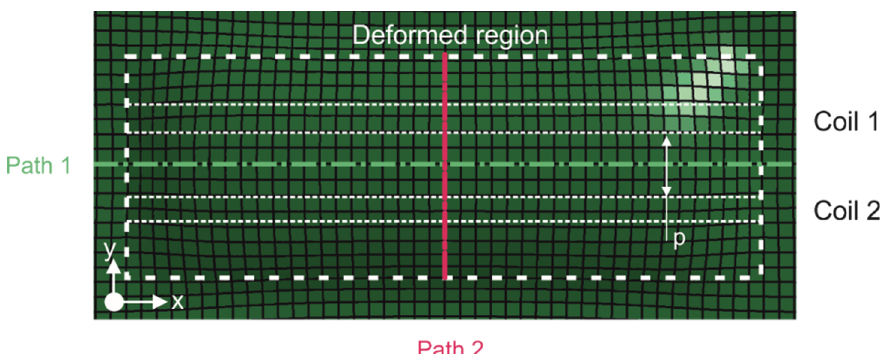
Figure 9. Two different paths chosen for comparison of plastic strains from the numerical and experimental analyses (top view).